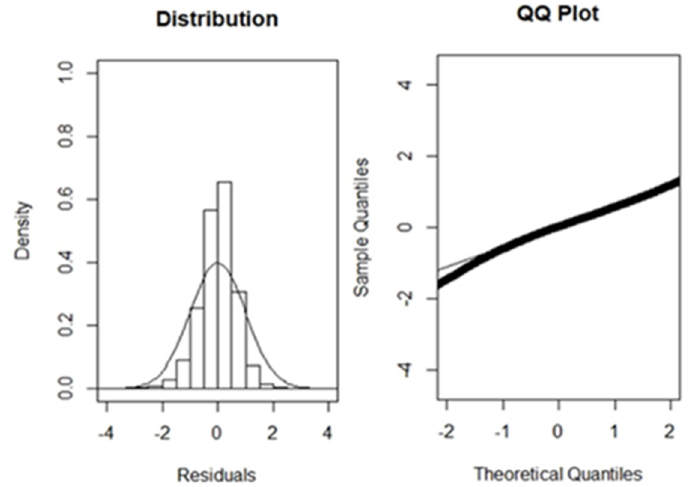
Figure 2. Residual distribution and quantile–quantile plot for selected generalized linear models for immature albacore tuna.